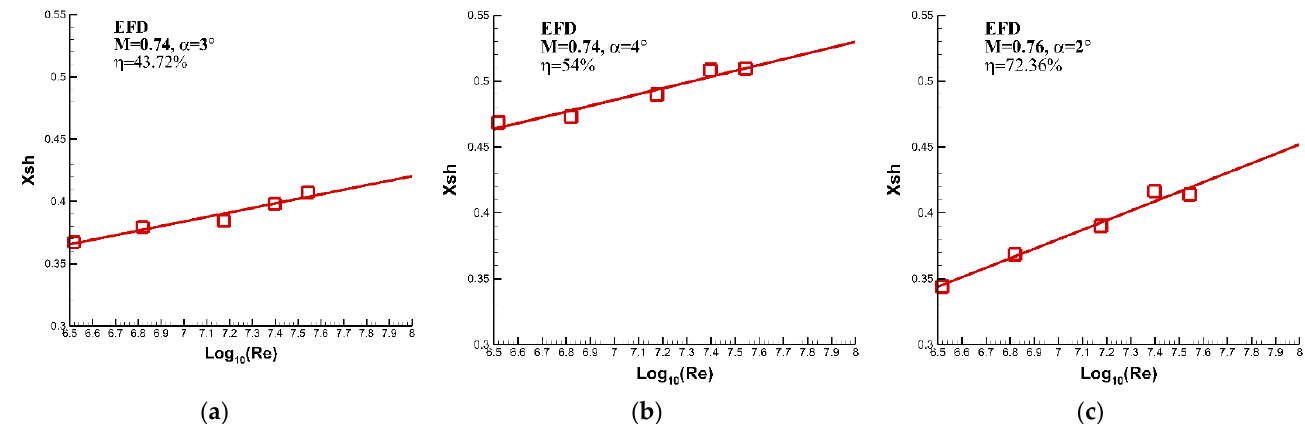
Figure 15. Reynolds number effect on shock wave position: ( a ) M = 0.74, α = 3°, η = 43.72%; ( b ) M = 0.74, α = 4°, η = 54%; ( c ) M = 0.76, α = 3°, η = 72.36%.